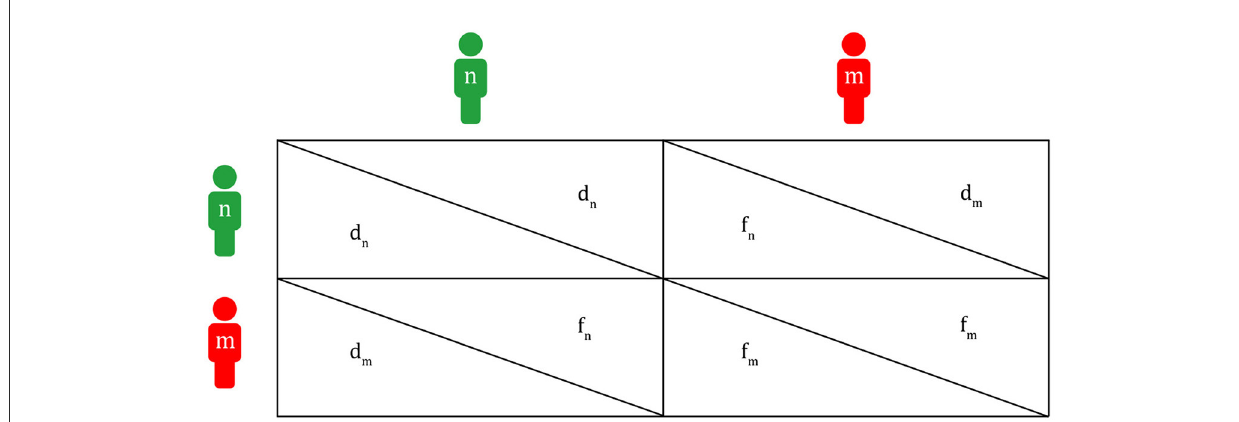
FIGURE3 Payoff matrix between a migraineur and a non-migraineur (m, migraineur; n, non-migraineur; f m , fitness of m when m meets m; f n , fitness of n when n meets m; d m , fitness of m when m meets n; d n , fitness of n when n meets n).